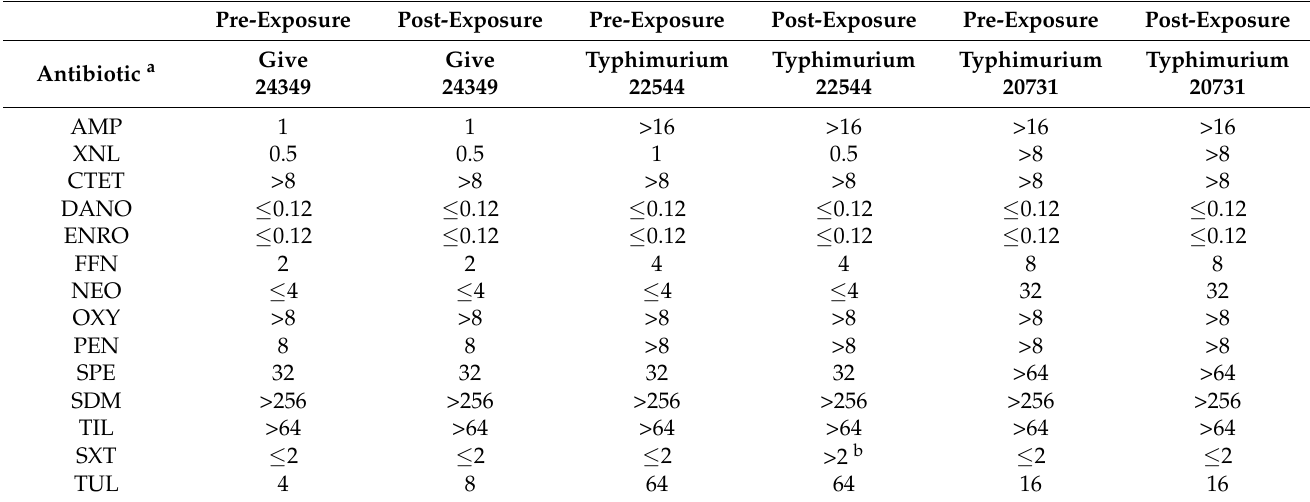
Table 5. Antimicrobial resistance profiles of stock multidrug resistant Salmonella enterica isolates provided by the US-FDA before and after intentional exposure to 0.5 mM of